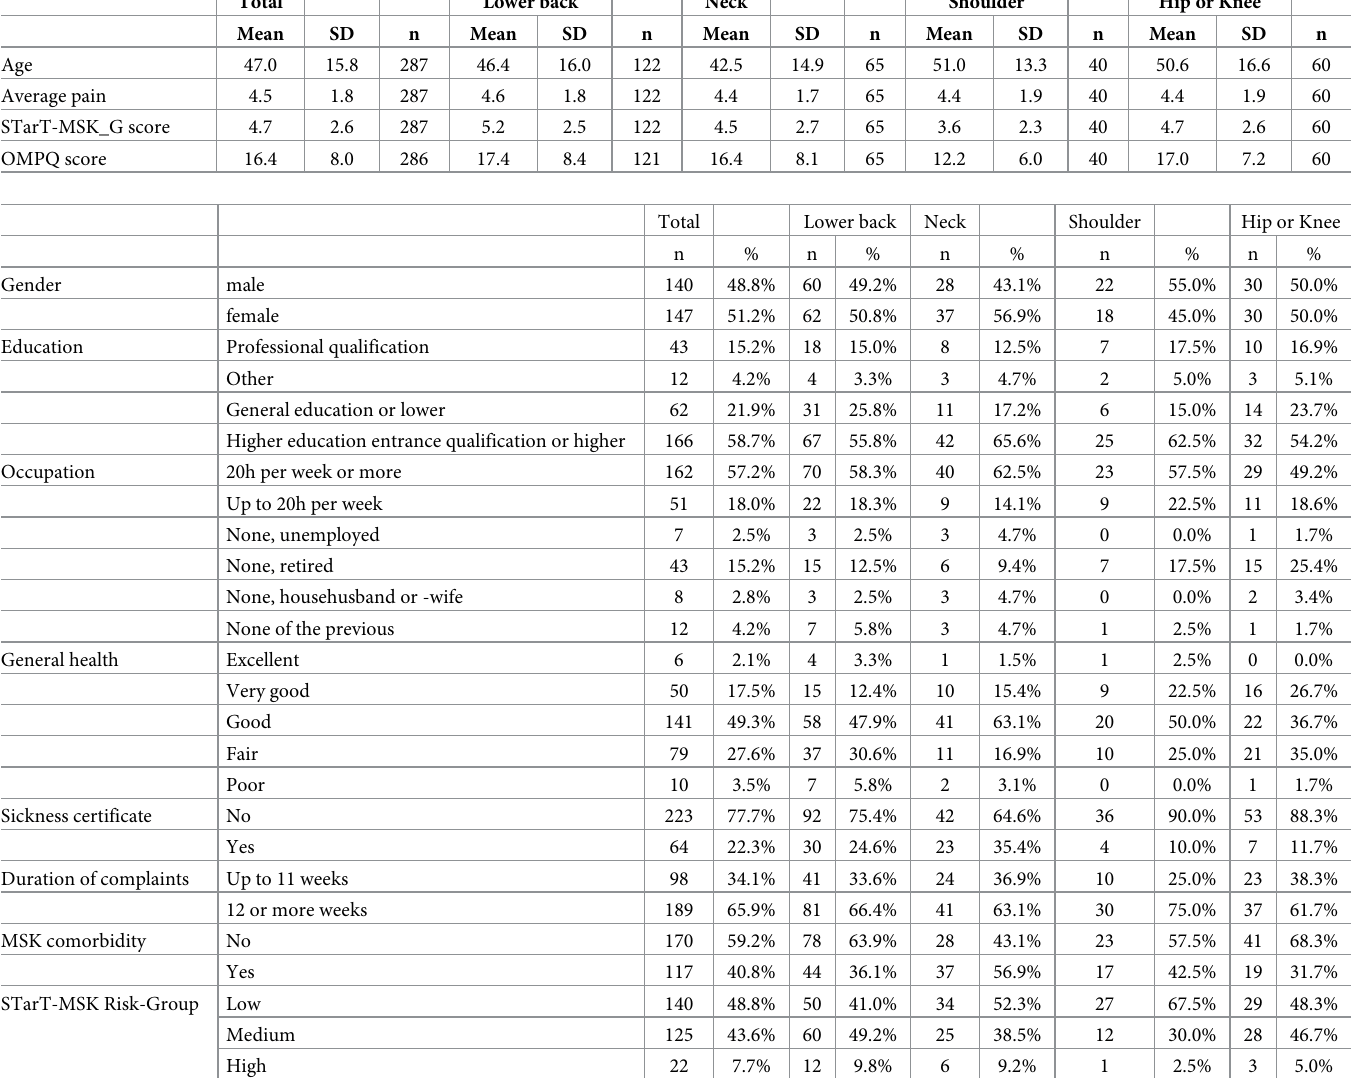
Table 1. Characteristics of the study